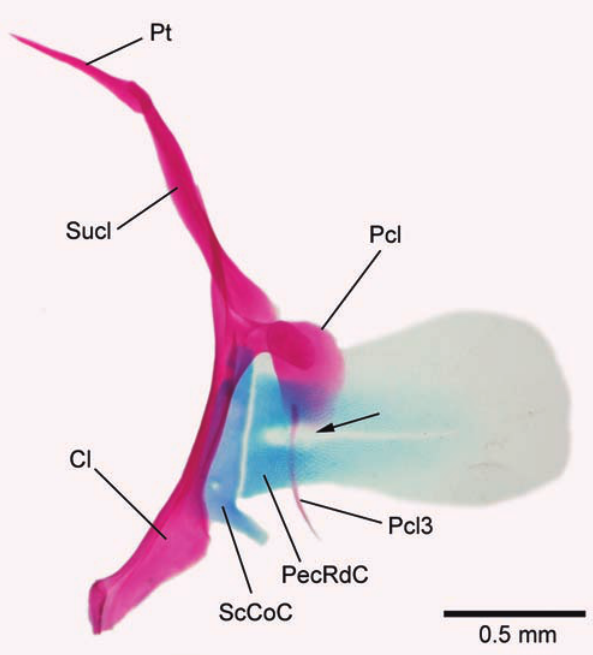
Fig. 3. Priocharax nanus , paratype, MZUSP 114015, 14.9 mm SL, c&s; shoulder girdle in lateral view. Cl = cleithrum; PecRdC = pectoral-fin radial cartilage; Pcl = unidentified postcleithrum; Pcl3 = postcleithrum 3; Pt = posttemporal; ScCoC = scapulocoracoid cartilage; Sucl = supracleithrum. Arrow points to middle incision on pectoral-fin radial cartilage. Scale bar = 0.5 mm.